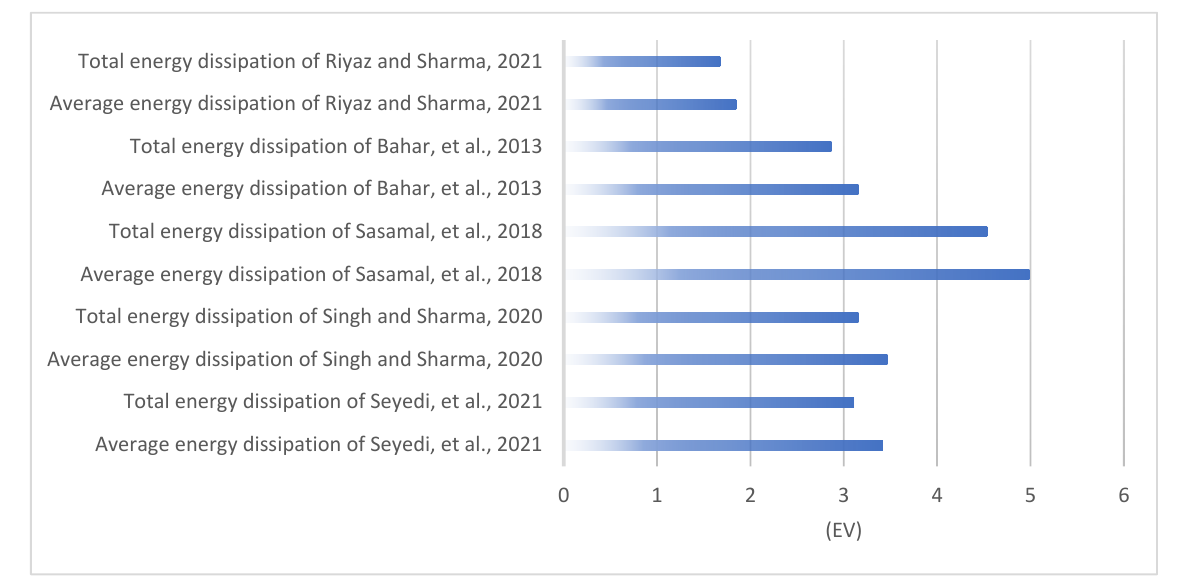
Figure 8. Energy dissipation of the proposed circuit [21-24, 29]. Table 1. Comparison of the proposed and literature